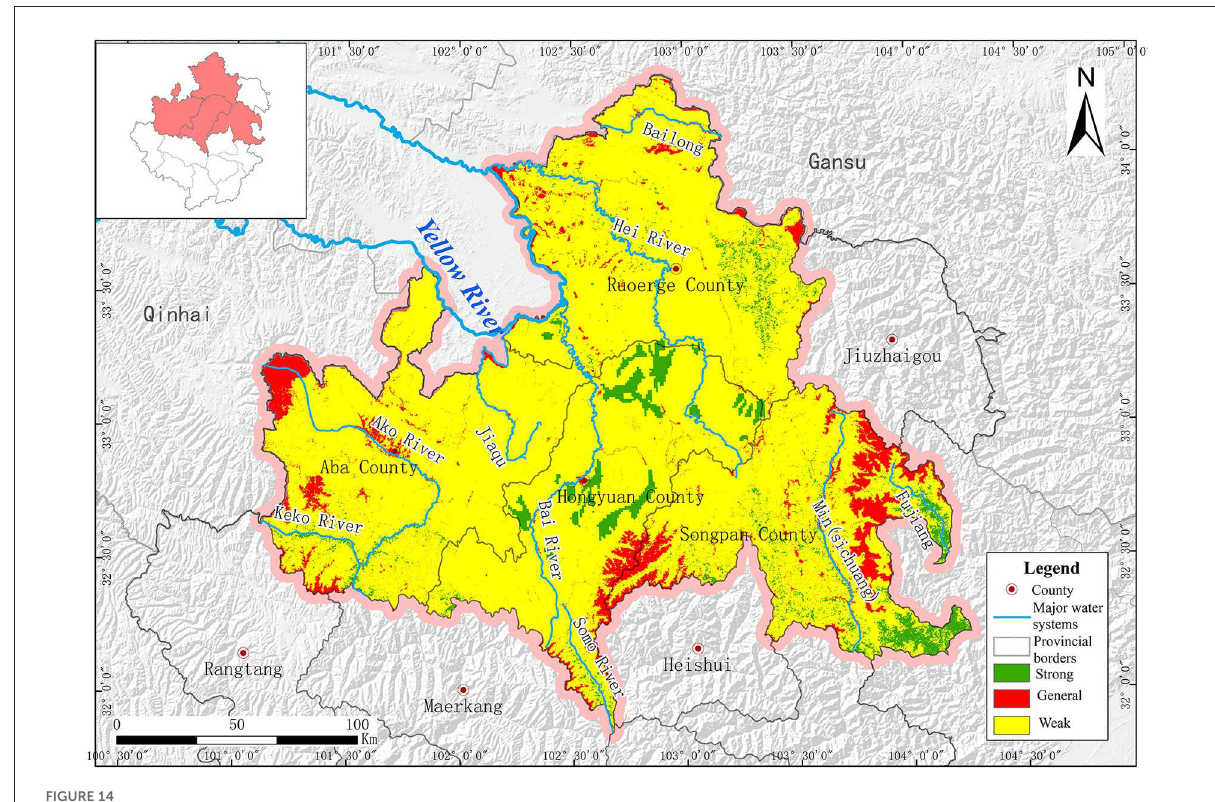
FIGURE14 Ecological restoration capacity assessment.